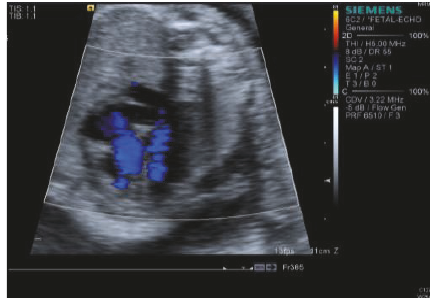
Figure 5: (No atrioventricular regurgitation. No cardiomegaly).